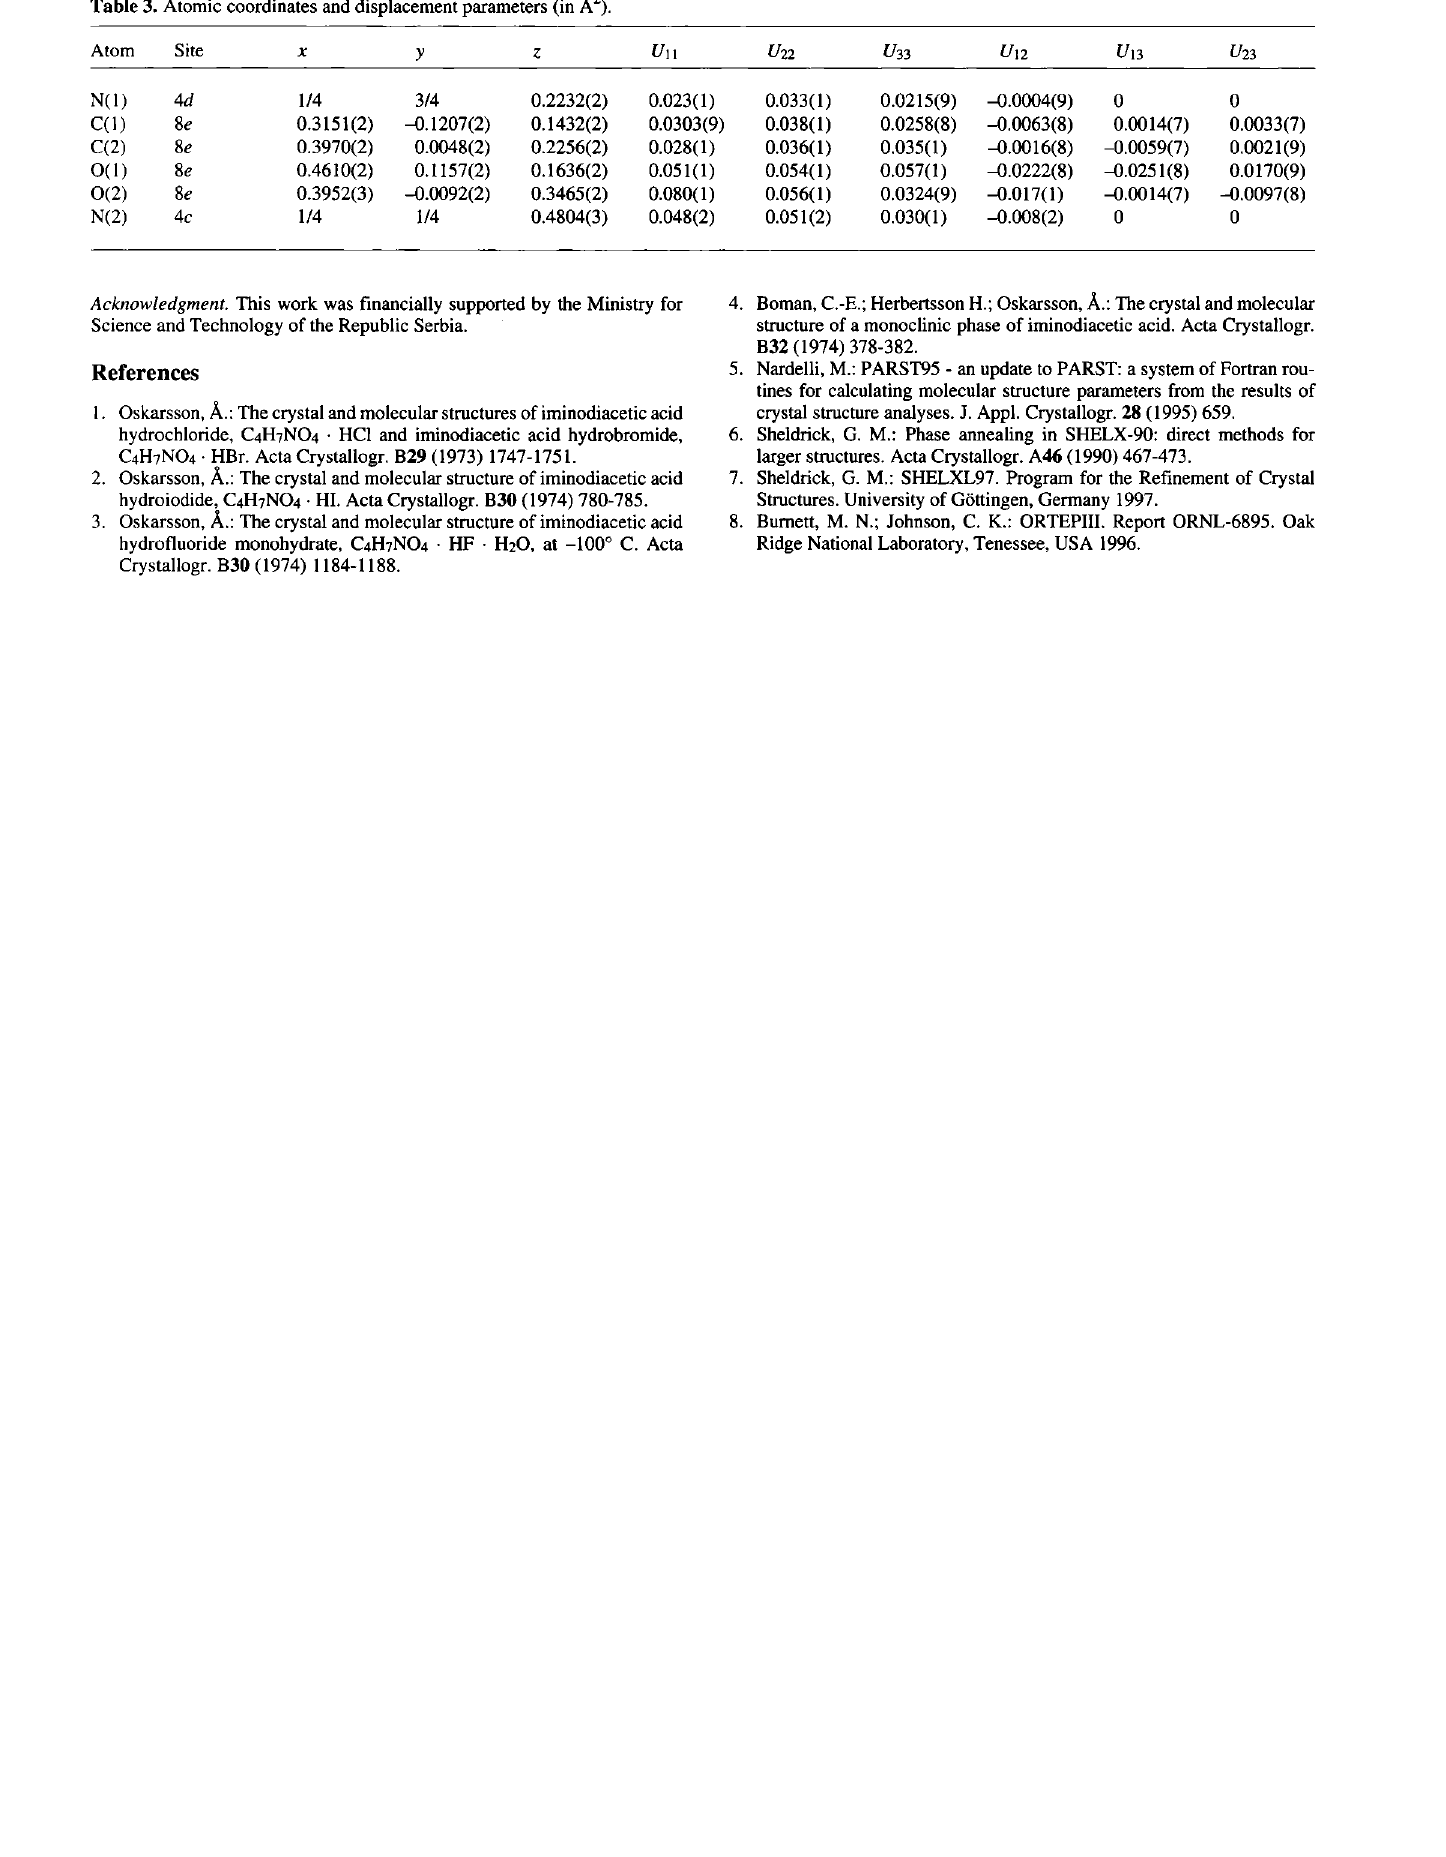
Table 3. Atomic coordinates and displacement parameters (in A 2